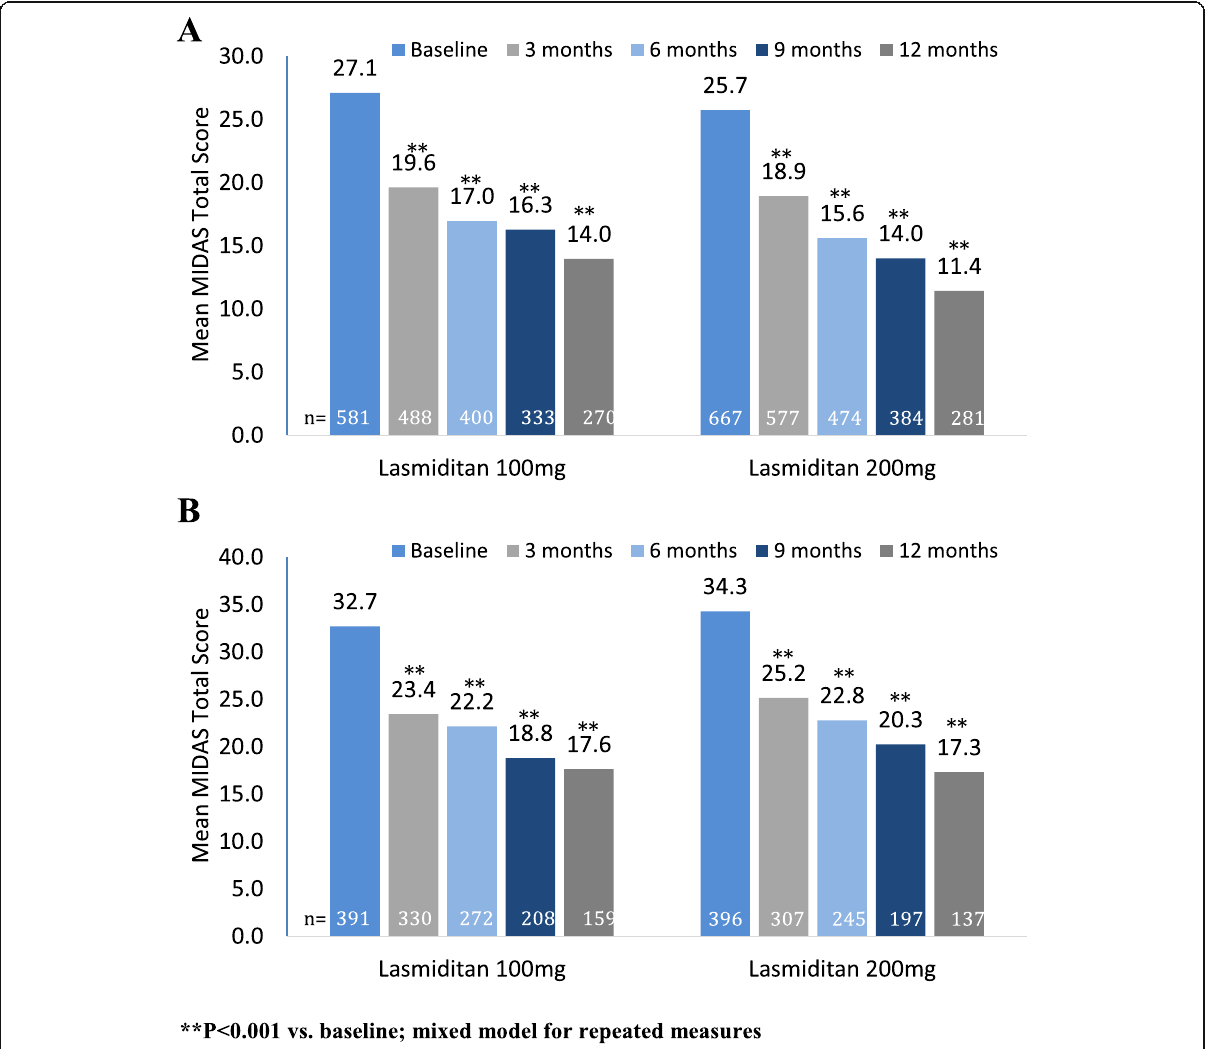
Fig. 4 Mean MIDAS score by study month in subgroups defined by monthly migraine attacks at baseline ( a ) ≤ 5 and ( b ) >5. ** P < 0.001 vs. baseline; mixed model for repeated measures. There were no significant differences between the lasmiditan dose